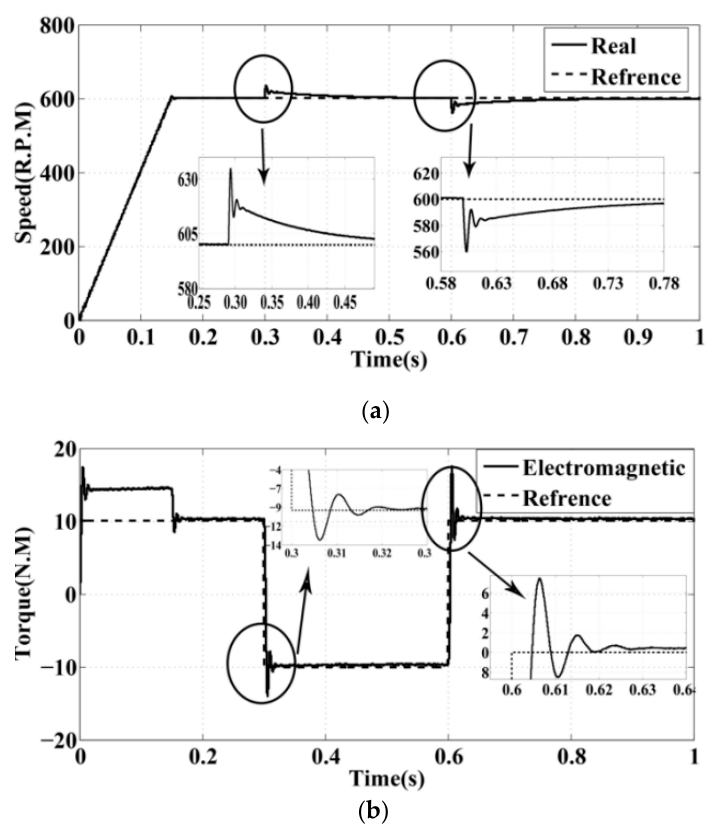
Figure 18. Characteristics of the motor compared with the reference (with applying step load). ( a ) Speed of the motor; ( b ) electromagnetic torque.